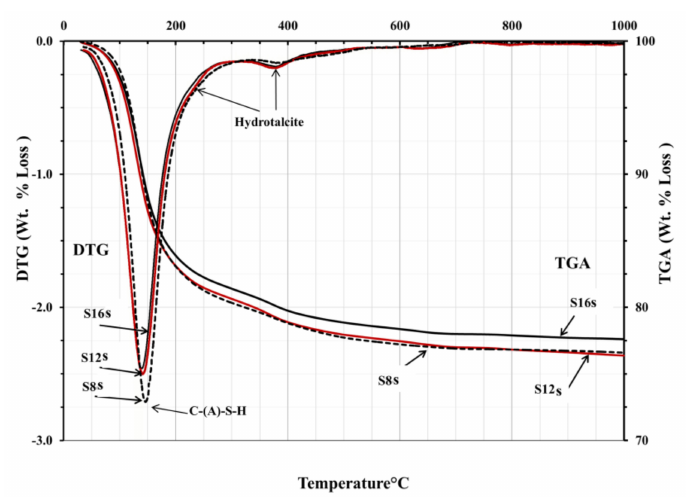
Figure 11. DTG and TGA results of AASs pastes activated with sodium silicate SS at age 28-day.